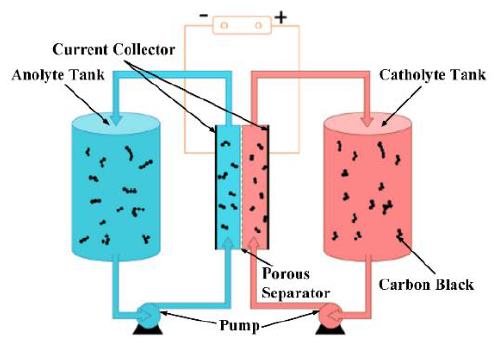
Figure 54. Schematic illustration of Type I redox flow batteries (RFB) design, which uses flowing carbon as electrochemical reaction electrodes [161].